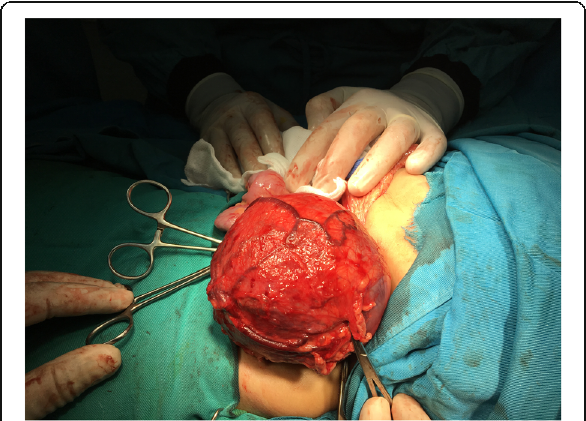
Fig. 2 Upfront nephrectomy